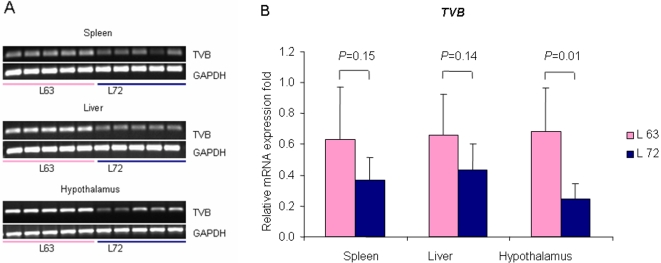
mRNA expression difference of TVB in line 63 and line 72.
P values indicates the statistical significance for the differences of relative TVB mRNA expression levels between lines 63 and 72 in spleen, liver, and hypothalamus, respectively. A: RT-PCR results. B: Real-time quantitative RT-PCR analysis. n = 5 for each line.